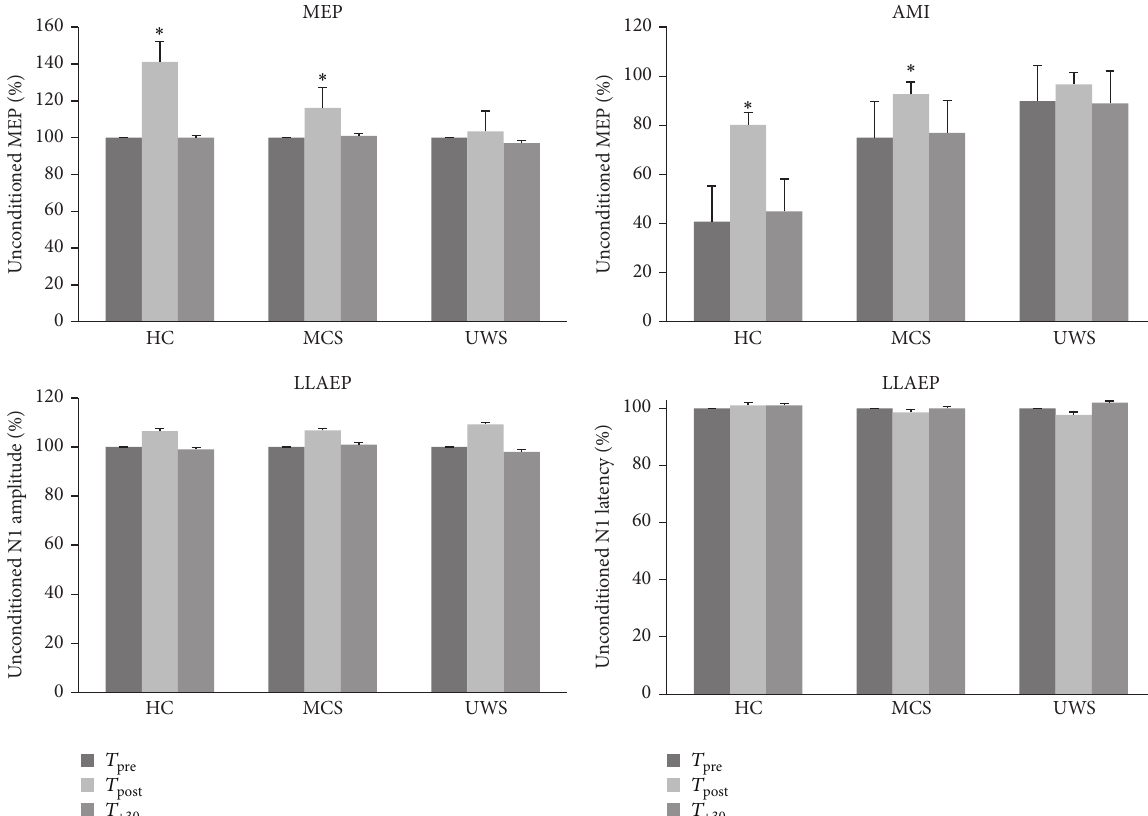
Figure2:Itshowstheelectrophysiologicalposteffectsinducedbythereal protocol.Weobservedasignificant,althoughshortlasting,increase of MEP and AMI amplitude in the HC and MCS patients, whereas the UWS patients did not show any significant effect. The latency and amplitude of LLAEP were affected in none of the groups. The values are reported as mean of the percent change in comparison to the baseline value. The error bars refer to the se. ∗ indicates a significant change ( 𝑝 < 0.05